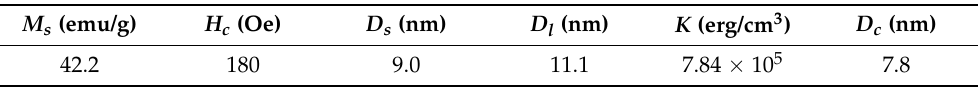
Figure 5. ( a ) Initial magnetization curve and ( b ) hysteresis loop of the NiFe 2 O 4 spinel ferrites. Table 1. Saturation magnetization ( M s ), coercivity ( H c ), particle diameters, and magnetic anisotropy constant ( K ) for the NiFe 2 O 4 sample.